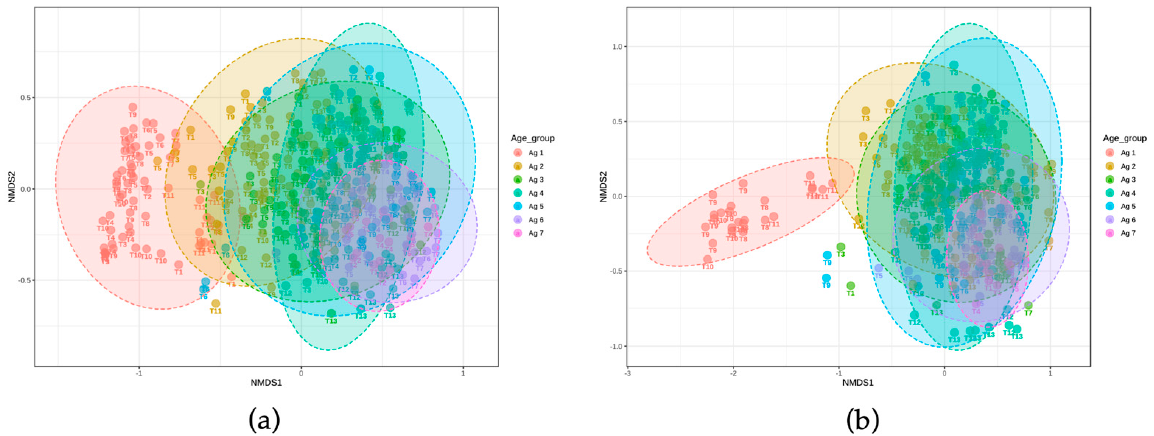
Figure 8. Beta diversity distances using the Bray Curtis measure based on OTU analysis according to age group and PMA treatment, ( a ) total DNA, ( b ) PMA-treated DNA. p -value indicates overall significant difference based on the Permanova test ( p = 0.025).